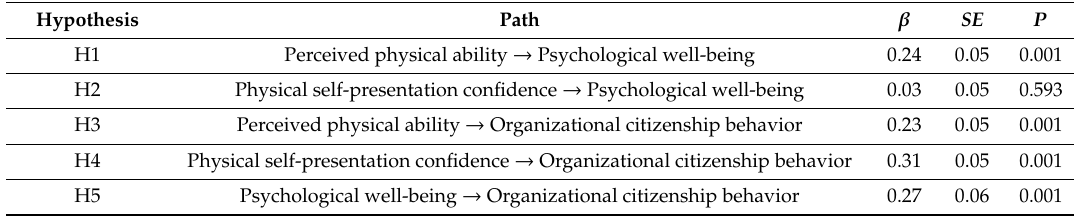
Table 4. Path Coefficients between Perceived Physical Ability, Physical Self-presentation Confidence, Psychological Wellbeing, and Organizational Citizenship Behavior.